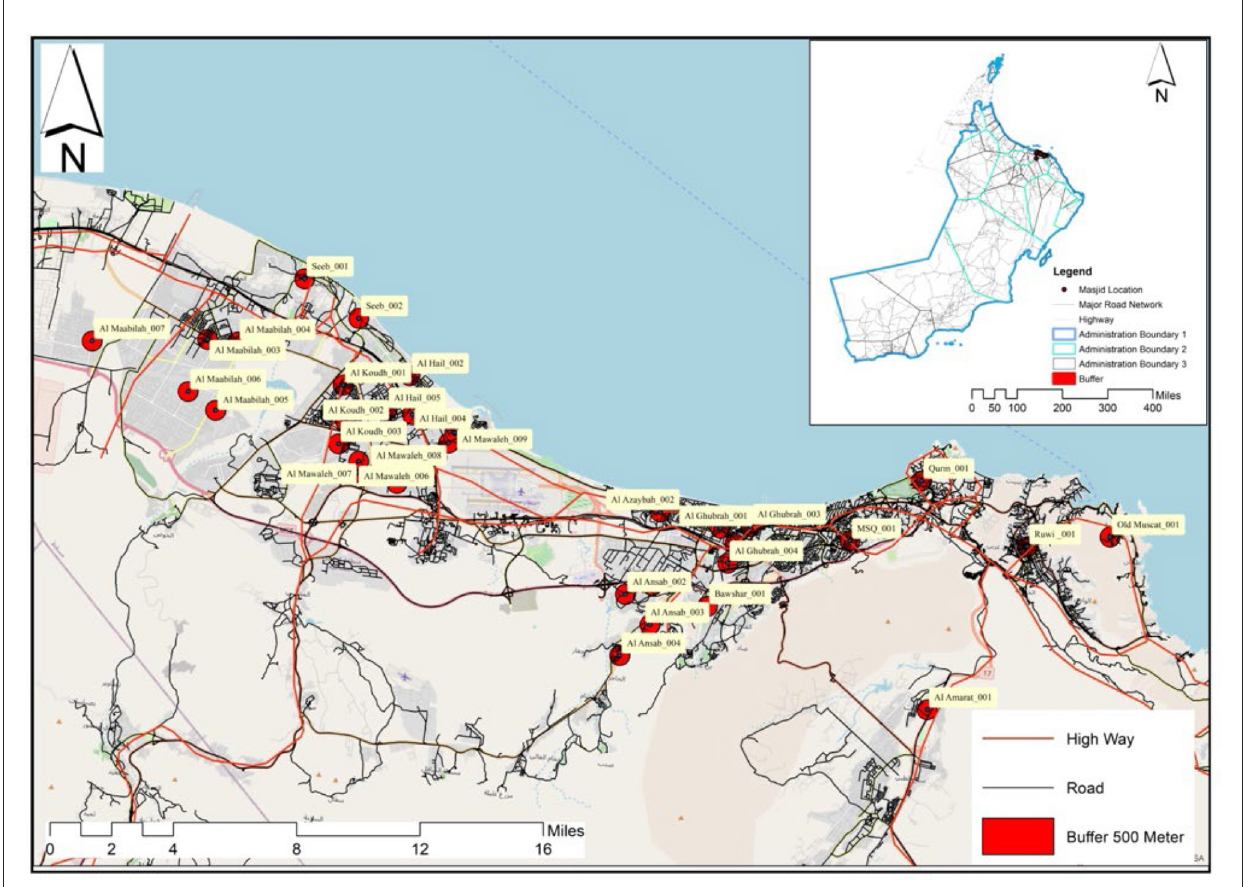
FIGURE1 Initial selection of potential study areas, Muscat,